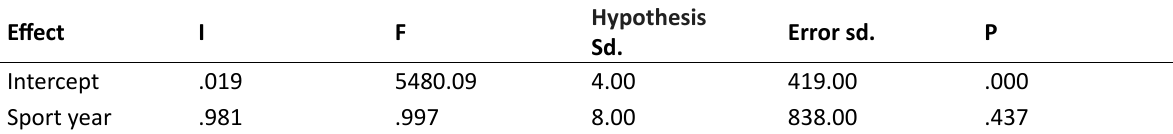
Table 2. Analysis of variance of the prosocial and antisocial behavior scores of athletes